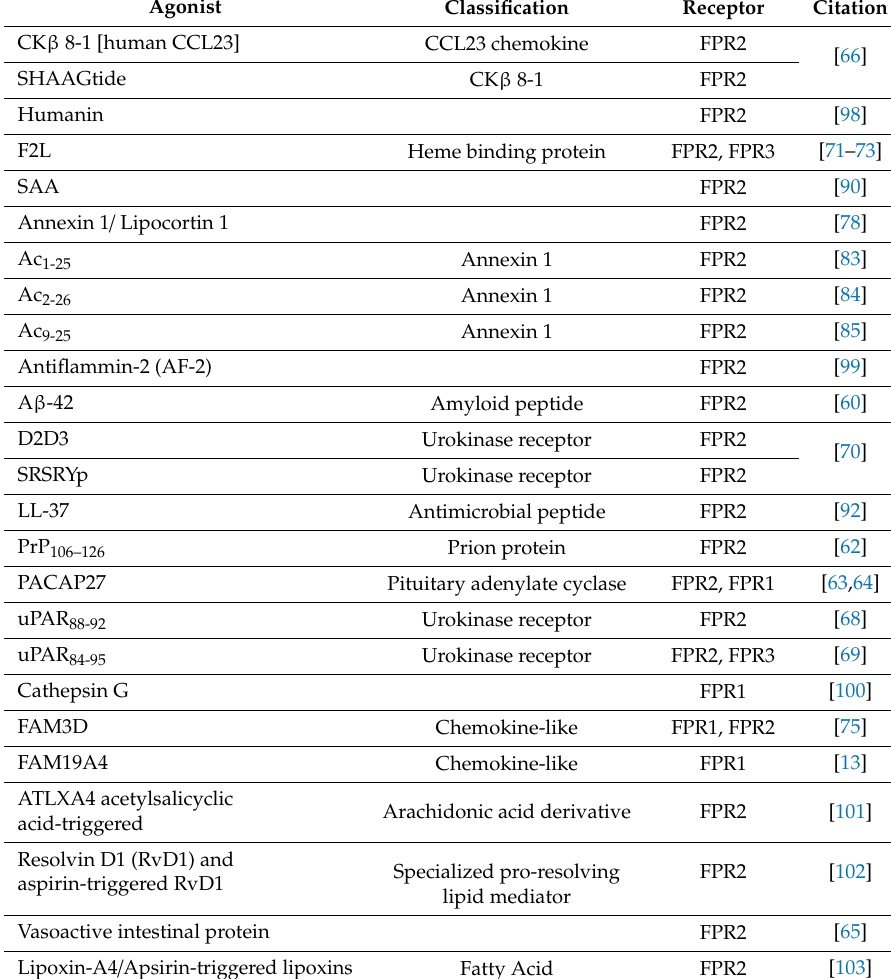
Table 4. Host-derived FPR (Fpr) ligands and their